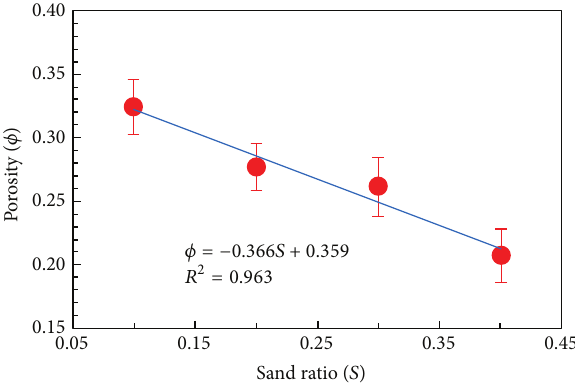
Figure 2: Porosity and sand ratio.